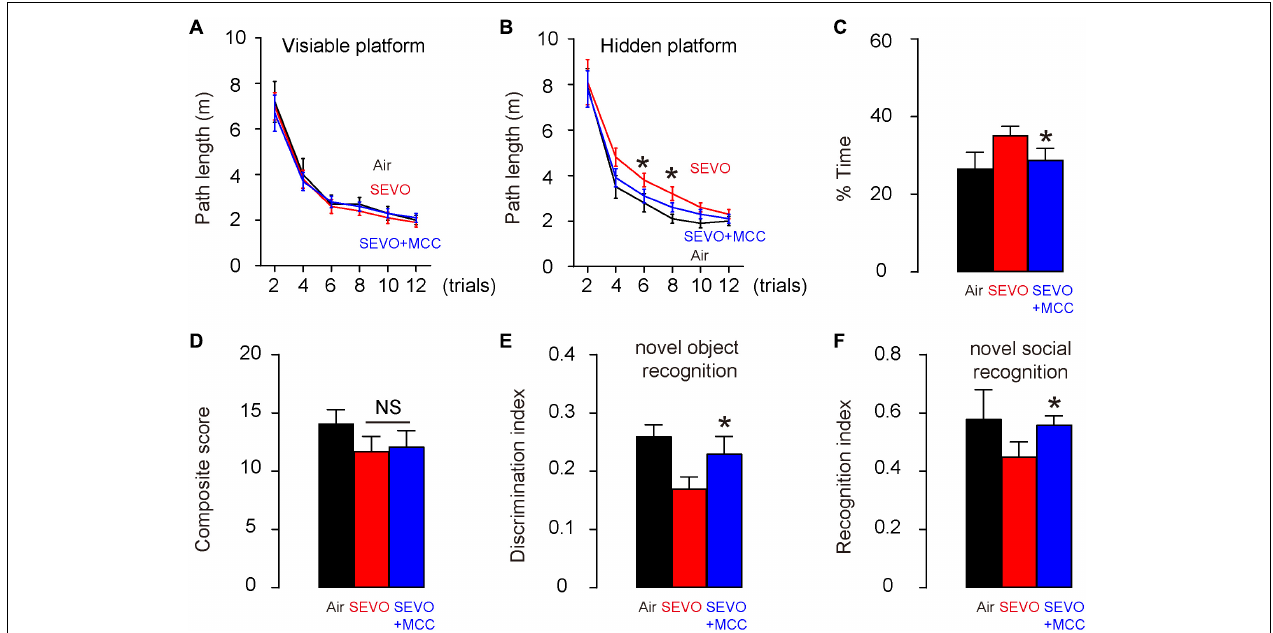
FIGURE 4 | Suppression of NLRP3 attenuates adverse effects of SEVO on spatial reference memory, sensorimotor, and cognitive function in AD-prone mice. Five interferences with the NLRP3 inhibitor, MCC950, at an interval of 2 h in between, was done, starting immediately before the SEVO/Air exposure (SEVO+MCC). The control mice received DMSO, the dissolving medium for MCC950 (SEVO). All AD-prone APP/PS1 mice of 3 months of age were then exposed to 5% SEVO for 8 h. Afterward, the mice were kept for another 2 months before assessment of their behavioral changes. (A–C) Morris water maze test for assessing spatial reference memory. (A) Path length in the visible platform phase. (B) Path length in the hidden platform phase. (C) Target quadrant occupancy. (D–F) Sensorimotor and cognitive test. (D) Composite score. (E) Novel object recognition task. (F) Novel social recognition task. * p < 0.05 (SEVO+MCC vs. SEVO). N = 10. N represents mouse number per experimental